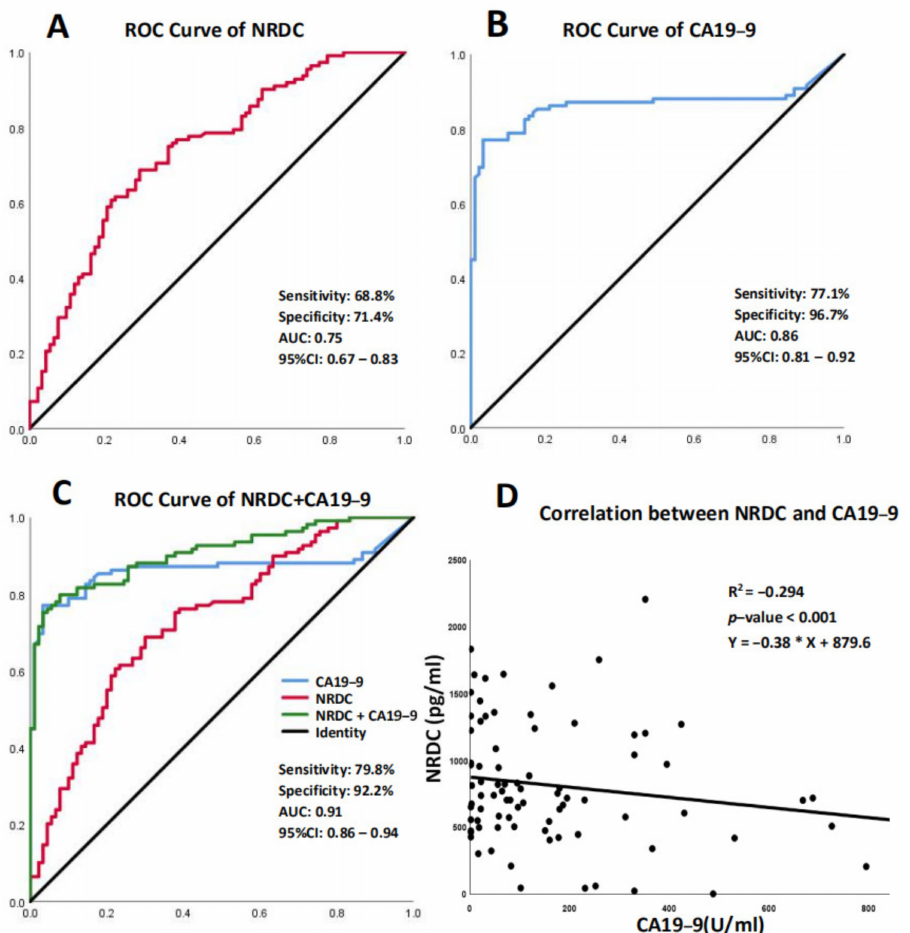
Figure 2. Receiver operating characteristic curve (ROC) analyses of serum NRDC and CA19-9 levels in the diagnosis of PDAC. ( A ) ROC curve of NRDC. ( B ) ROC curve of CA19-9. ( C ) ROC curve of NRDC, CA19-9 and combined group, the sensitivity, specificity, AUC and CI of combined group were shown. ( D ) Correlation analysis between NRDC and CA19-9 in PDAC